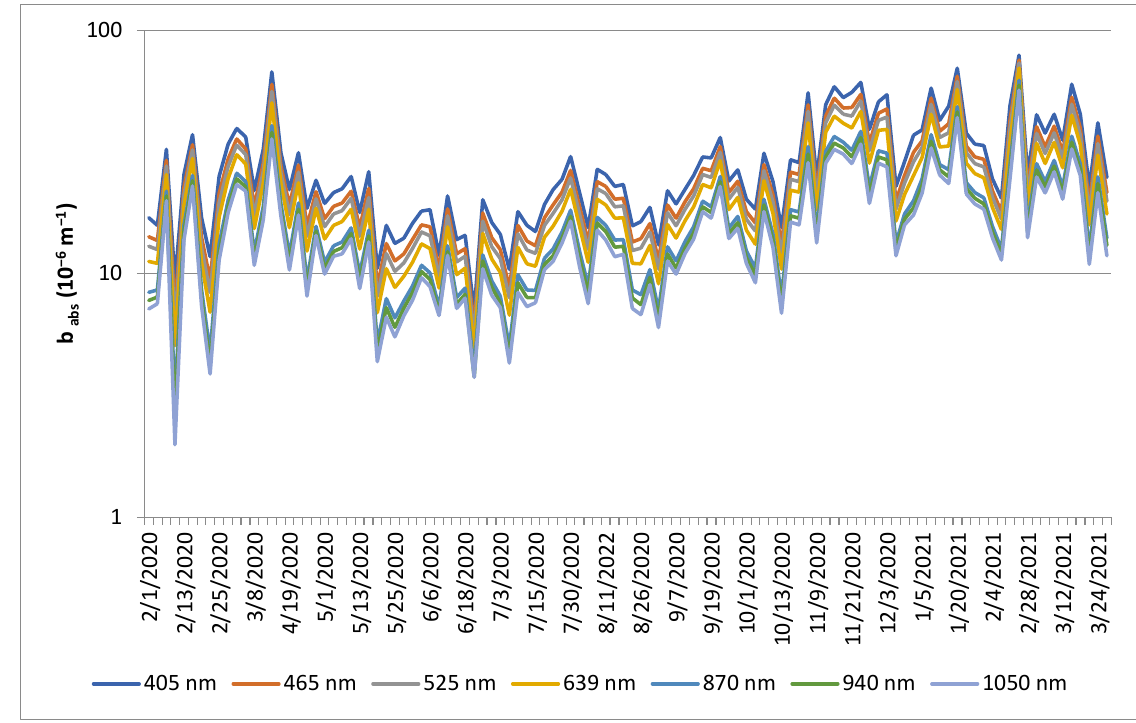
Figure 2. The mass absorption coefficient ( ε ) versus wavelength ( λ ) obtained for sampling from the Krakow site.